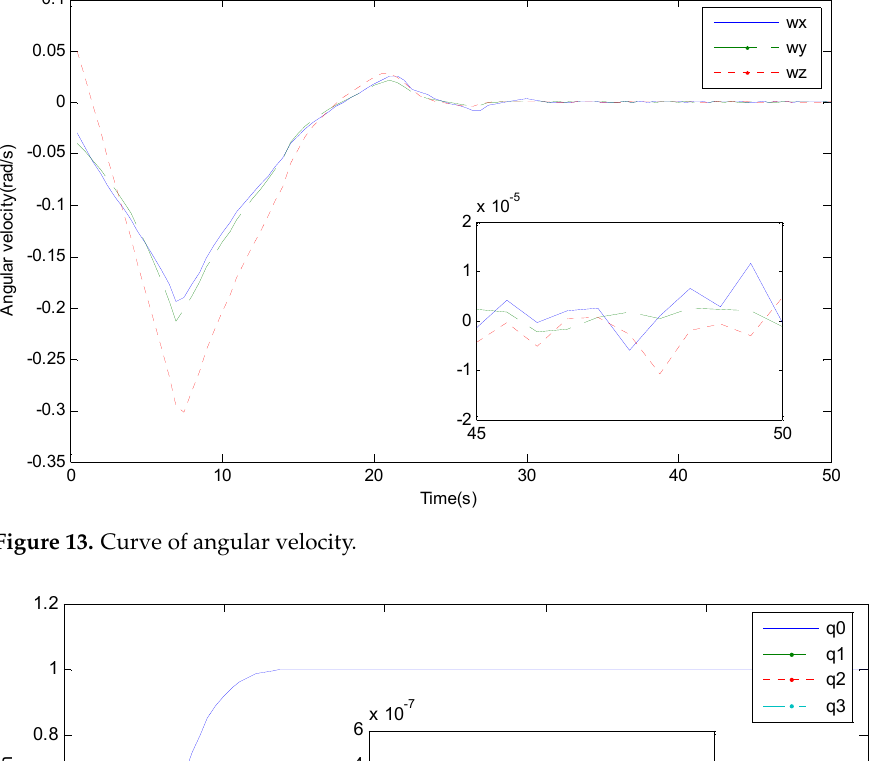
Figure 13. Curve of angular velocity.